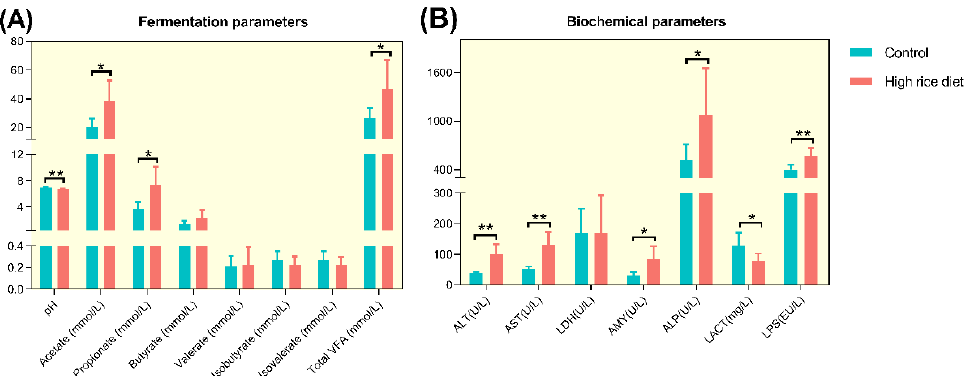
Figure 8. ( A ) Comparison of colonic pH and short-chain fatty acids (SCFAs) among dietary treatments in goats. ( B ) Comparison of the colonic biochemical parameters between dietary treatments in goats. “*” means that the difference between the two groups is significant ( p < 0.05), and “**” means that the difference between the two groups is extremely different ( p < 0.01).